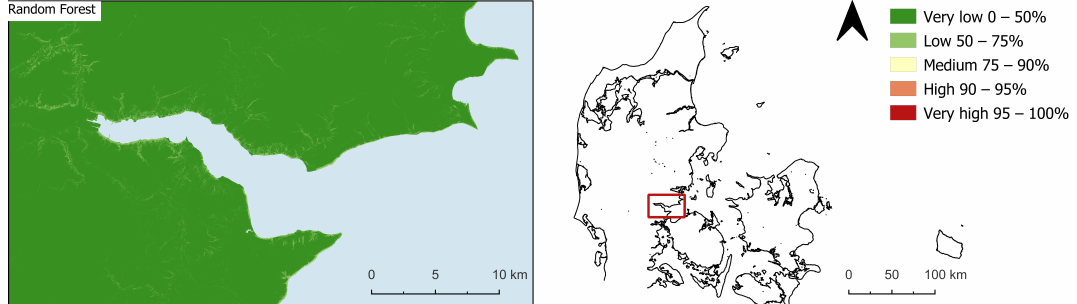
Figure 12. Landslide susceptibility map—future scenario RCP8.5 for